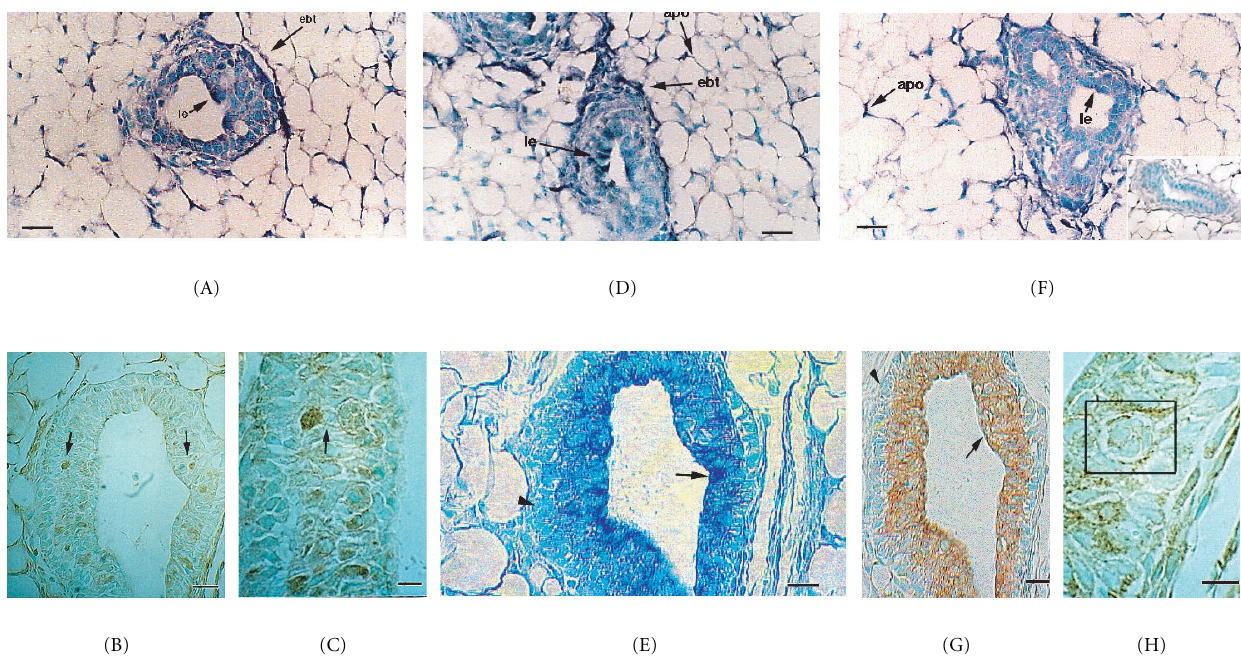
Figure 3: α -catenin, β -catenin, and E-cadherin expression in 6 week-old mammary glands. (A) Mammary section hybridized with digoxigenin-UTP-labeled probe for α -catenin mRNA. Note in end bud tip (ebt), fibroblasts (f), and luminal epithelium (le) express α - catenin. (B–C) Association of α -catenin protein expression and transitional unit (boxed areas) in the TEB. Note in (C), α -catenin expressing cellandcytoneme.(D) 6 week-oldmammarysectionhybridizedwithdigoxigenin-UTP-labeledprobefor β -cateninmRNA.(E) β -cateninim- munostaining outlines the luminal epithelial cell layer of the 6 week-old TEB. (F) 6 week-old mammary section hybridized with digoxigenin- UTP-labeled probe for E-cadherin mRNA. (G–H) E-cadherin immunostaining in 6 week-old glands. Note E-cadherin expression outlines the luminal epithelial cell layer of the 6 week-old TEB, but negative staining occurs in the transitional unit (boxed area). All sections were collected according to materials and methods. Insets in (A–B, D–G) control probed tissue, respectively. Scale bars (A–B) 50 µ m, (C) 24 µ m, (D–E) 50 µ m, (F–G) 50 µ m, and (H) 24 µ